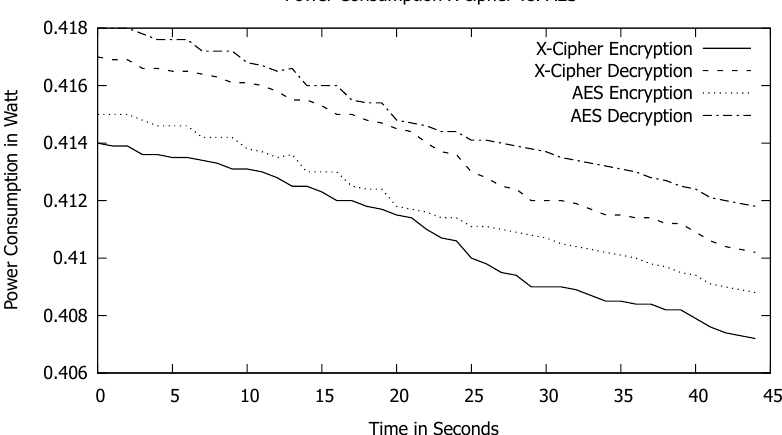
Figure 8. Power Consumption during encryption and decryption processes for AES and